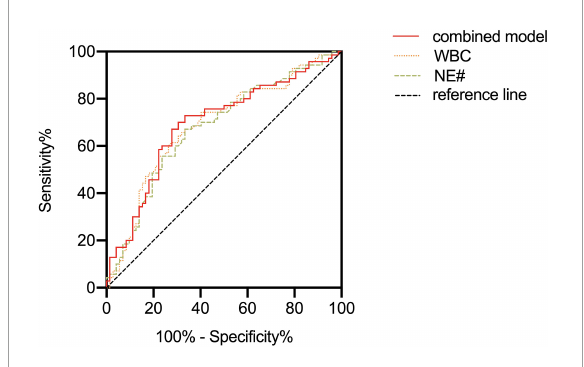
FIGURE5 Receiver operating curves (ROC) characteristic of maternal white blood cell (WBC), NE#, and combined model were utilized to analyze the accuracy of maternal blood parameter levels to predict fetal ventriculomegaly